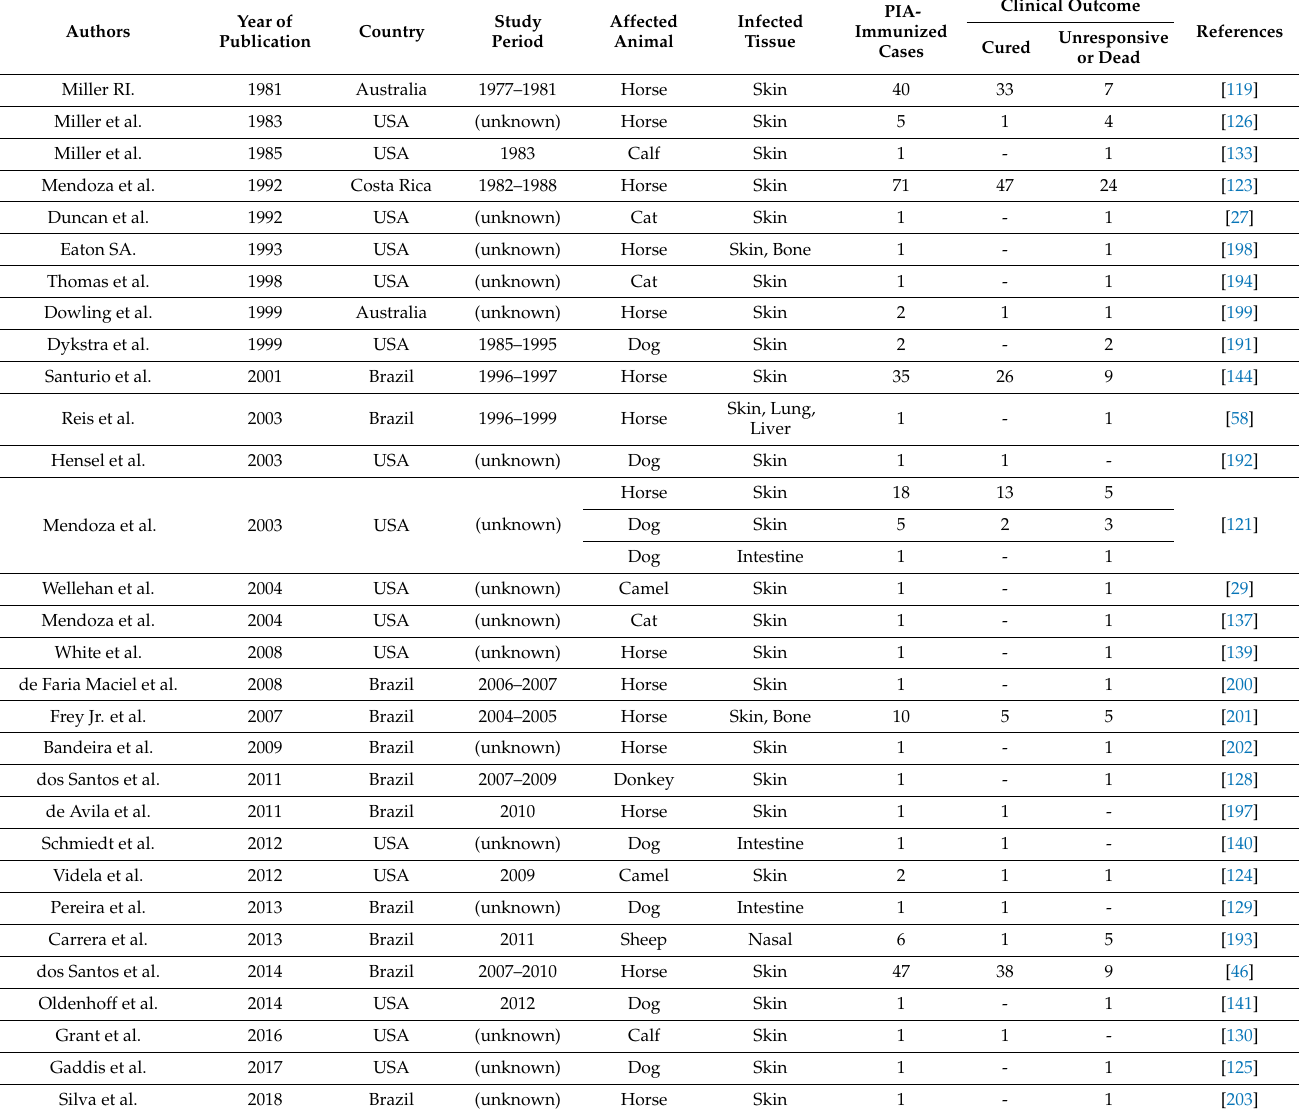
Table 4. Animals with pythiosis (270 cases) receiving the P. insidiosum antigen (PIA) immunotherapy during